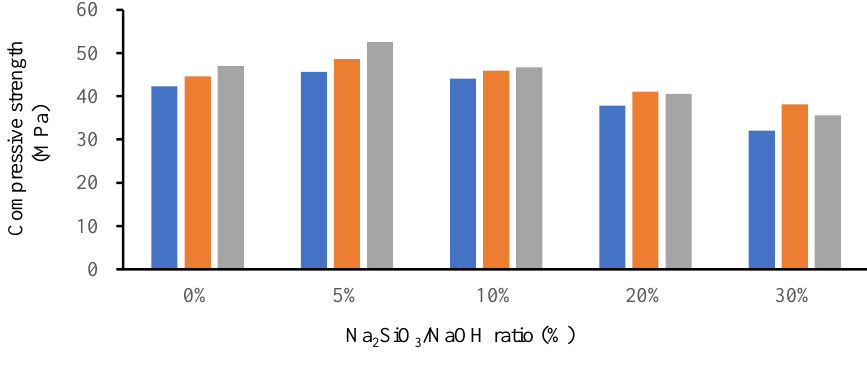
Figure 13. Compressive strength test results for the geopolymer specimen using various Na2SiO3-to-NaOH and FA-to-GGBS ratios with sand preheated at 110 °C and cured in a hot oven at a uniform temperature of 50 °C for 3 h.